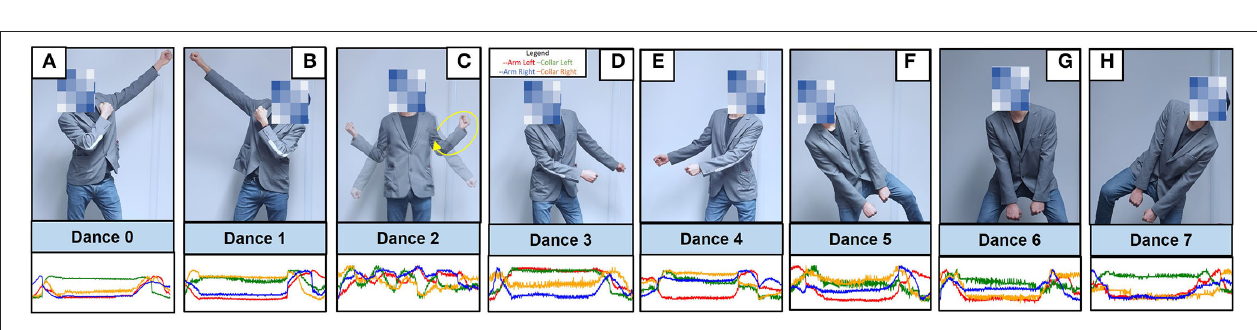
FIGURE 3 | (A–H) Eight dance movements dictionary with example signals. x = (0,400) time steps, y :norm(0,1).